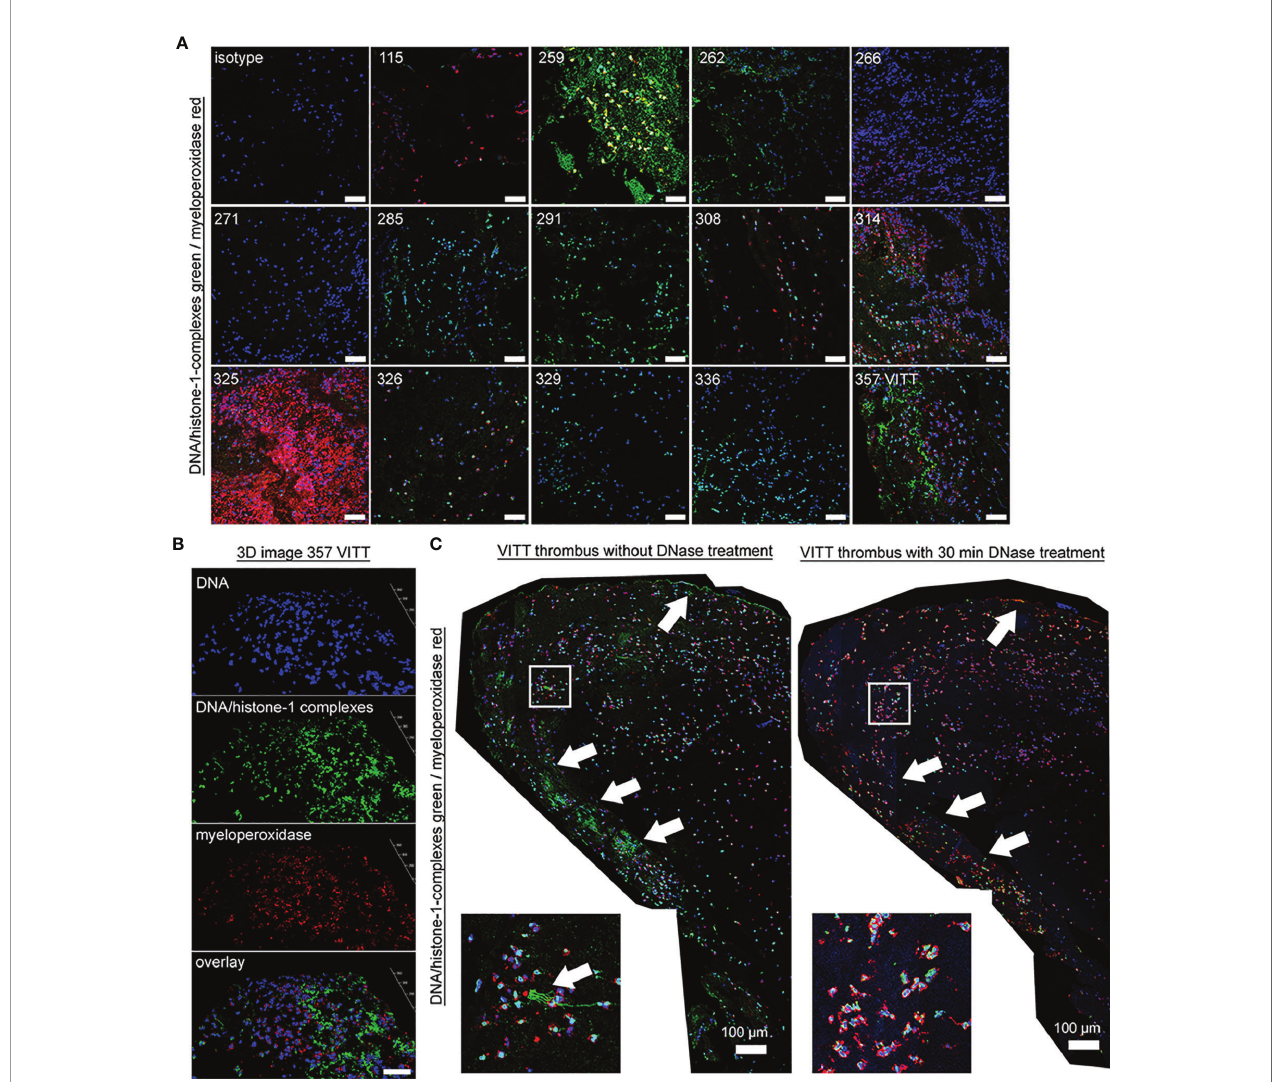
FIGURE 2 | Speci fi c NET markers in thrombi of VITT and controls are detectable. (A) NET markers DNA/histone-1-complexes (green) and myeloperoxidase (red) were stained in extracted thrombi of the VITT-patient (357) and all 13 control patients (blue = DNA). Microscope settings were adjusted to the presented isotype control and exemplary pictures are presented. (B) 3D image of z-stacks from VITT-thrombus were constructed with LAS X 3D Version 3.1.0 software (Leica), (6.21 µm consisting of 38 sections, scale bar = 50µm.) (C) Stitched images show distribution of NETs inside the VITT-thrombus (blue = DNA, green = DNA-histone-1- complex, red = myeloperoxidase). White arrows depict strong NET signals (DNA-histone-1-complex and myeloperoxidase) in the left panel, especially in the outer range. A zoom picture of the white squared area is presented. Speci fi city of NET markers were identi fi ed after DNase degradation. Serial cuts of thrombi were treated during the NET-staining with and without DNase for 30 minutes at 37°C. DNase treatment deletes the DNA-histone-1-complex from thrombus section, but not the myeloperoxidase. The settings were adjusted to a respective isotype control (with and without DNase